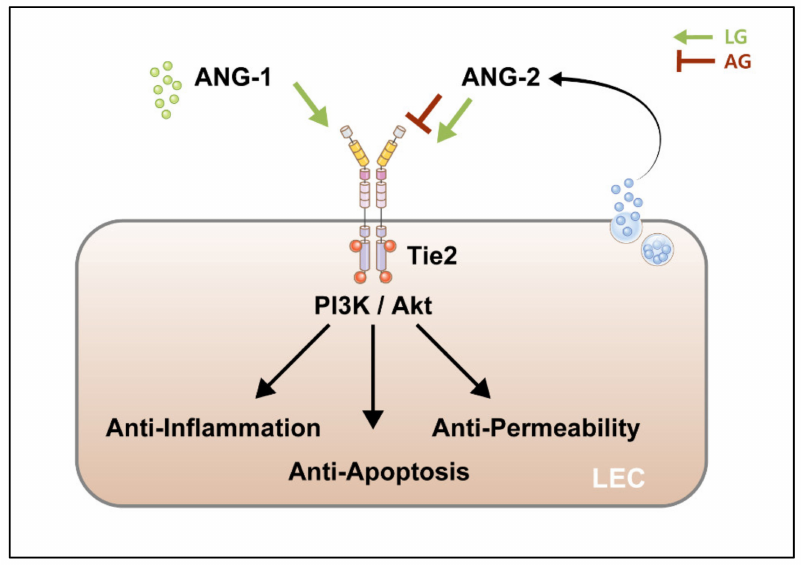
Figure 3. Schematic illustration of current understanding of angiopoietins and Tie receptor activation. ANG, angiopoietin; LEC, lymphatic endothelial cell; LG, lymphangiogenesis; AG,